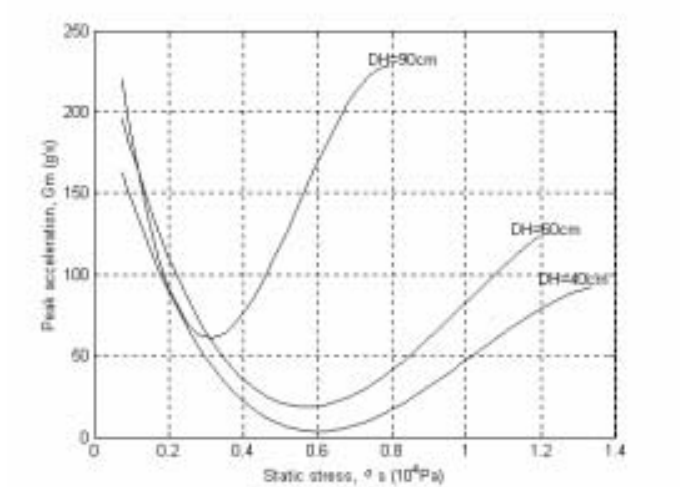
Fig. 6. Dynamic cushion curves of honeycomb paperboard ( T = 30 mm).